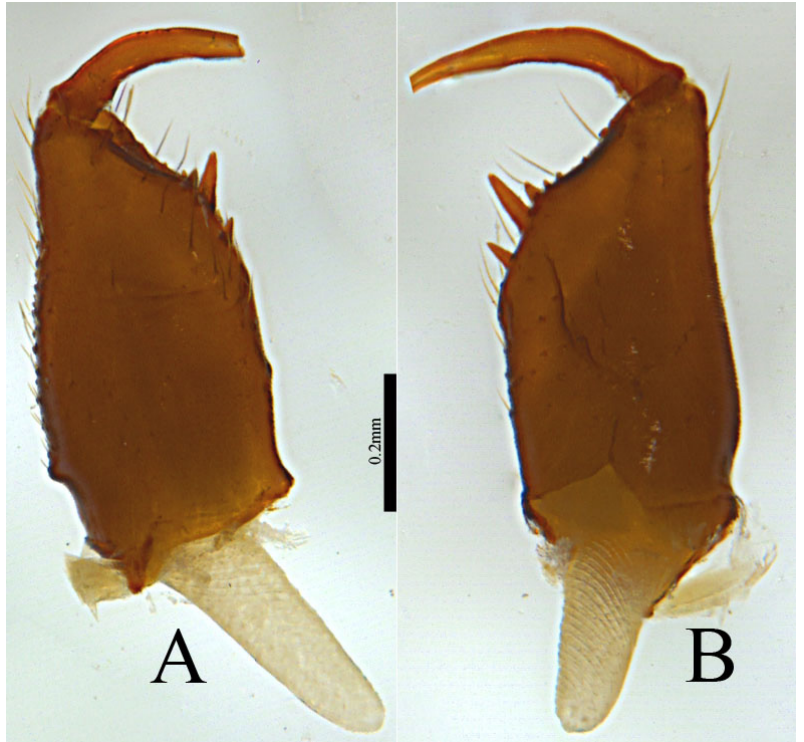
Fig. 5. Acroterius brevis gen. et sp. nov., ♂, holotype (HNU-20040501–1). A . Chelicera, dorsal view. B . Chelicera, ventral